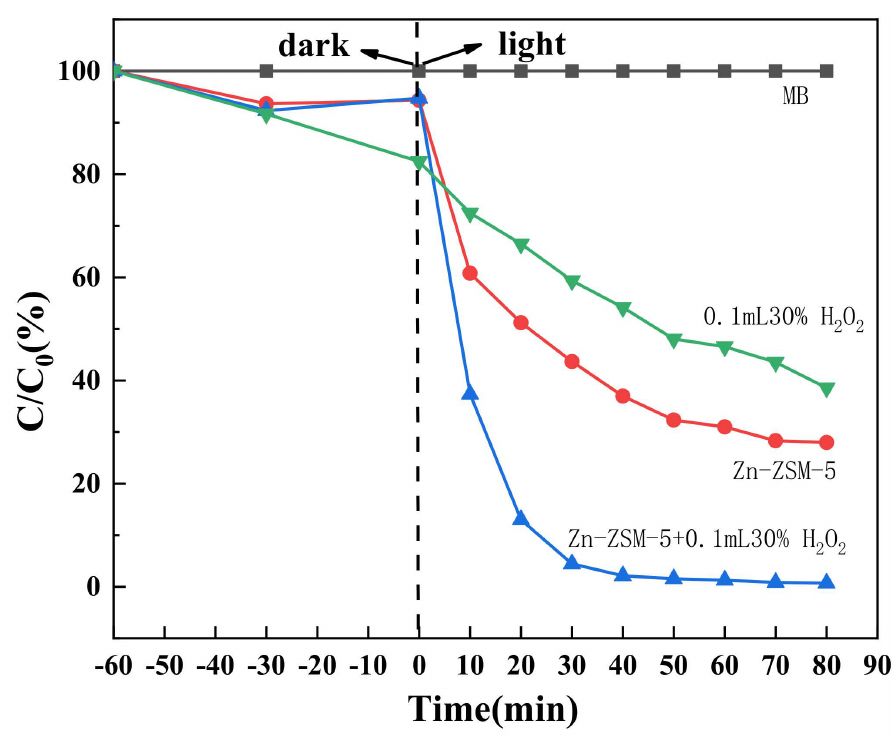
Figure 9. Effect of solution system on photocatalytic